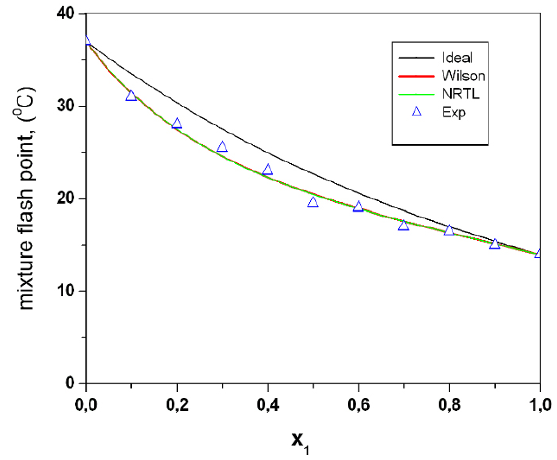
Figure 4. Comparison of the flash point prediction curves with experimentally derived data for 4-methyl-2-pentanone (1) +1-butanol